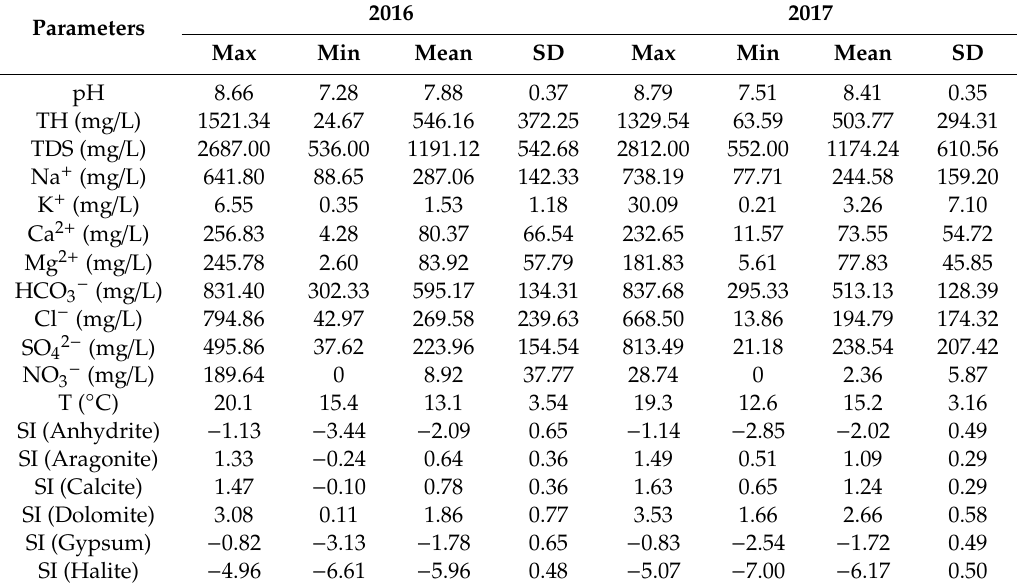
Table 3. Descriptive statistics of the major parameters of